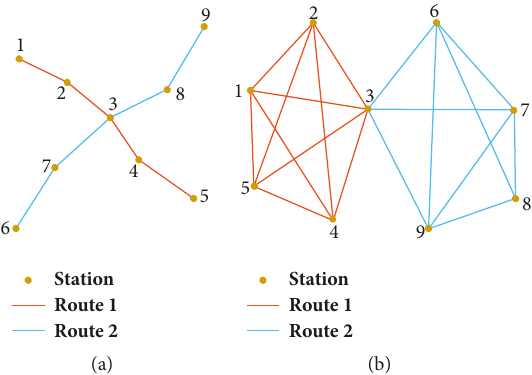
Figure 1: (a) A railway network consists of two train routes, train route 1 in orange and train route 2 in blue. (b) The P-space network formed by the two train routes in Figure 1(a), where the orange lines denote node pairs connected through the train route 1, and the blue lines denote node pairs connected through train route 2.